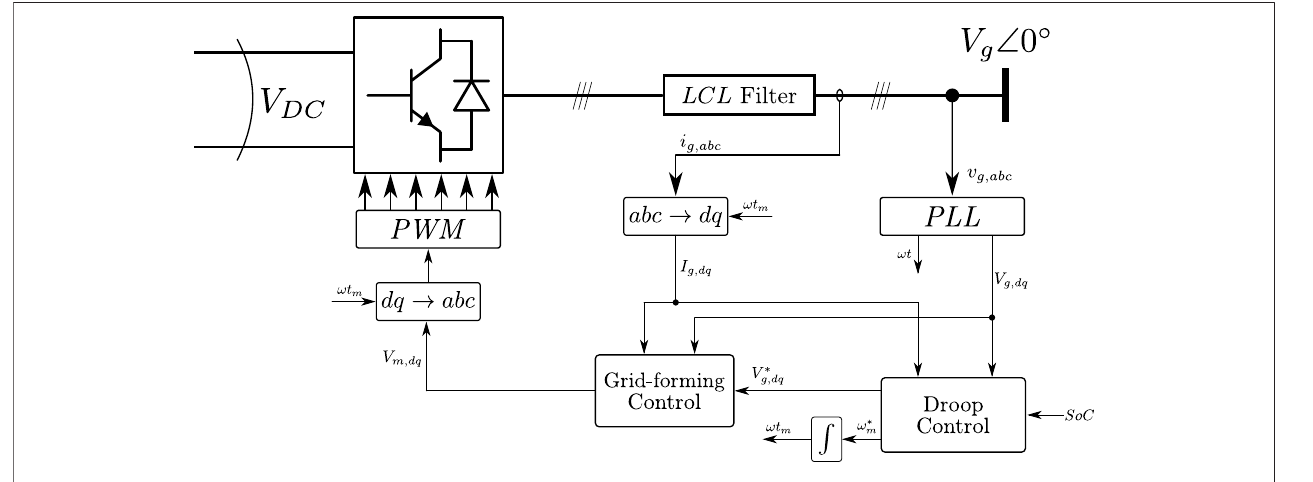
FIGURE 2 | Simpli fi ed scheme of the Grid-forming